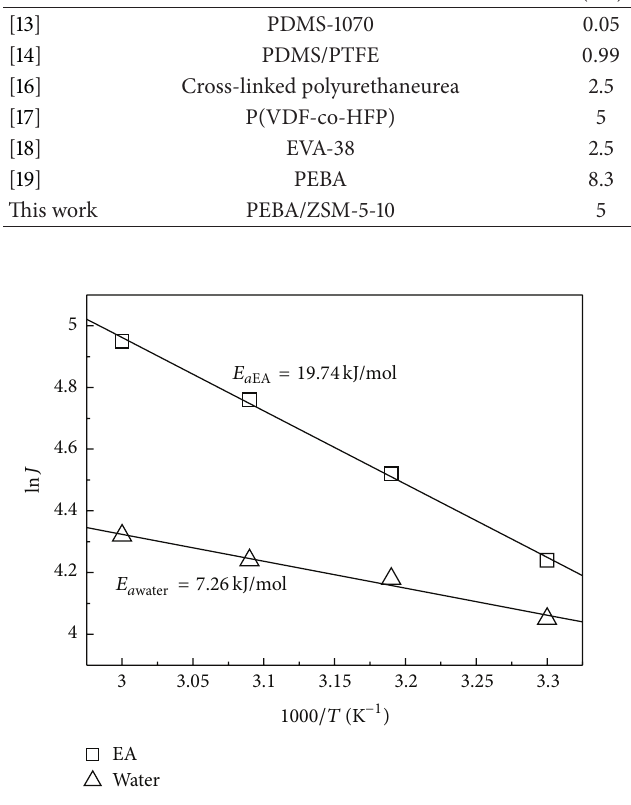
Figure 10: Arrhenius plots of PEBA/ZSM-5-10 membrane.